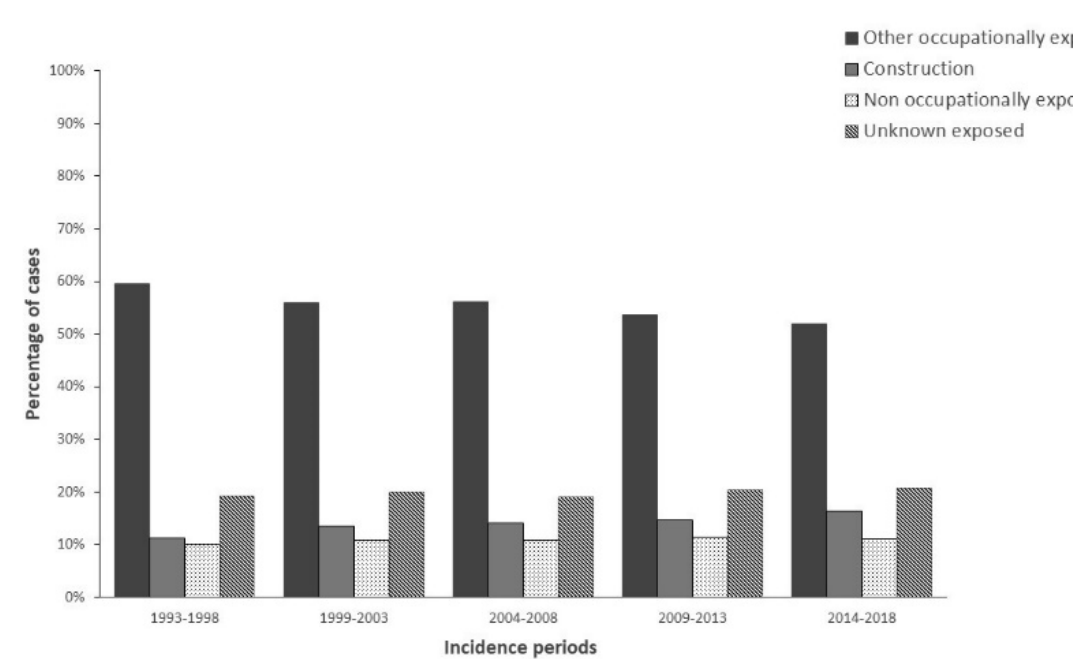
Figure 2. Distribution of MM cases (%) by exposed groups and time-period. Italy, ReNaM,